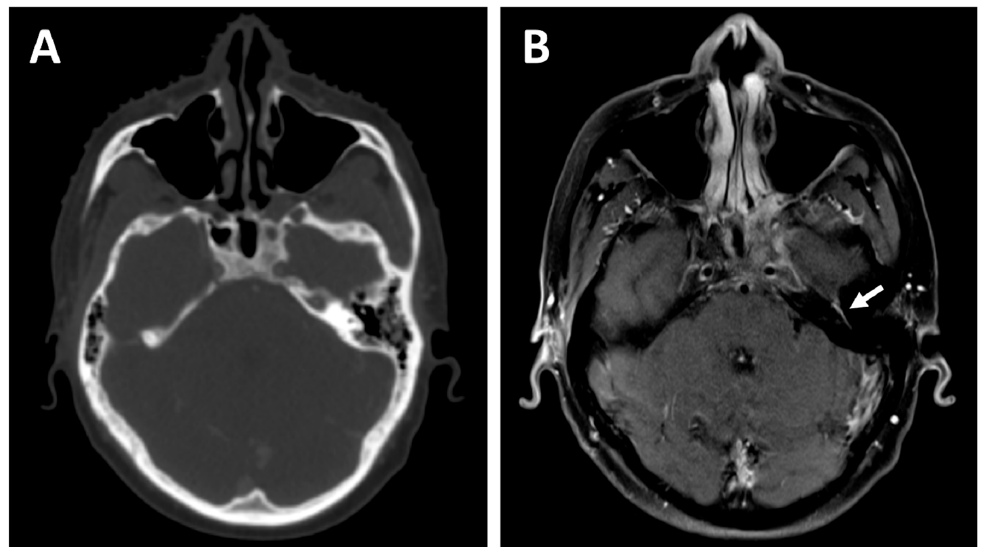
Figure 1. A 27-year-old patient with a cT4N2 undifferentiated carcinoma of the nasopharynx who